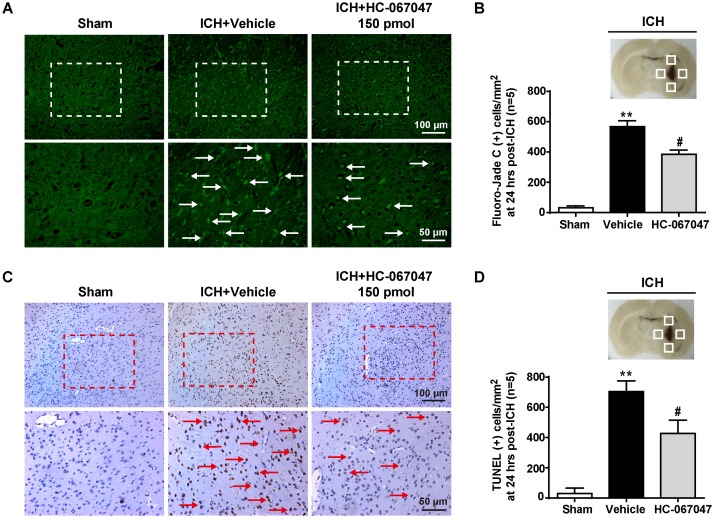
The effects of HC-067047 administration on neuronal damage after ICH. (A) Representative images of F-JC staining and (B) quantitative analyses of F-JC-positive neurons in sham, vehicle, and HC-067047 treatment groups (150 pmol per rat) 24 h after the operation are shown. Scale bar: 100 or 50 μm. (C) Representative images of TUNEL staining and (D) quantitative analyses of TUNEL-positive cells in the sham, vehicle, and HC-067047 treatment groups (150 pmol per rat) 24 h after the operation are shown. Scale bar: 100 or 50 μm. The schematic diagram shows the four areas (white squares) used for counting F-JC positive cells (white arrows in panel A) and TUNEL positive cells (red arrows in panel C) in the perihematomal region, n = 5 rats per group. Data are presented as the means ± standard errors of the means. ∗∗p < 0.01 compared with the sham group; #p < 0.05 compared with the vehicle group.